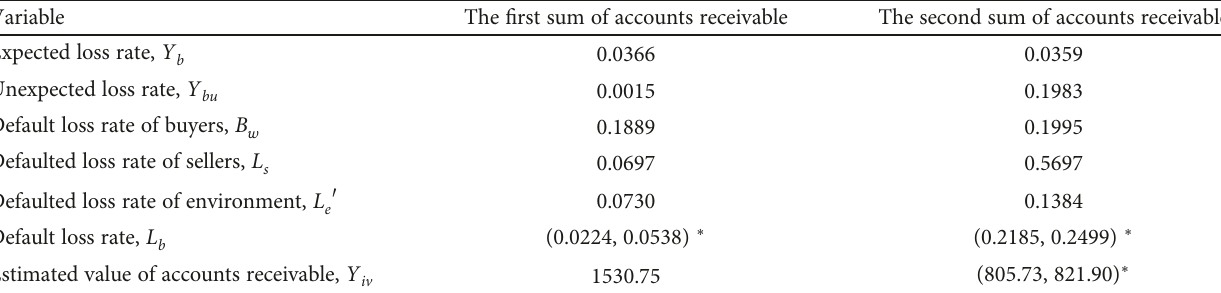
Table 12: Results.